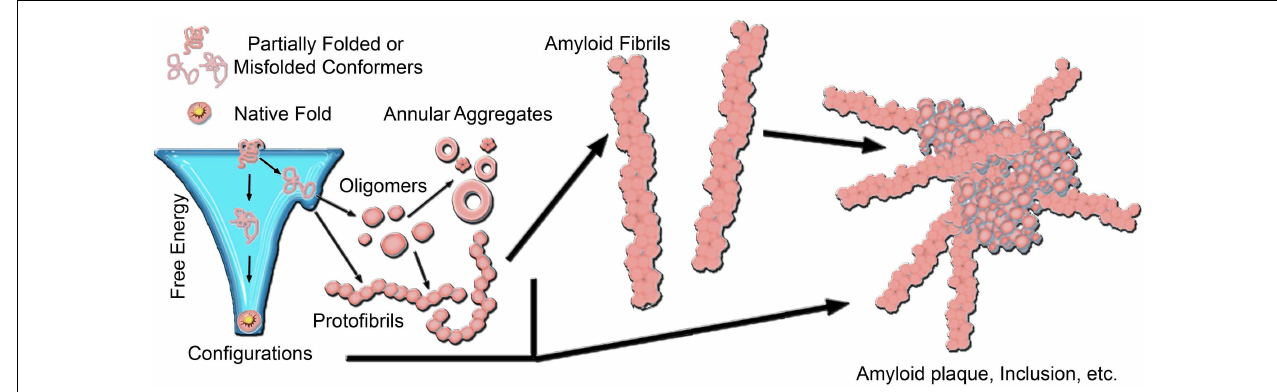
a heterogeneous mixture of intermediate species, including oligmers and protofibrils. Off-pathway aggregates can also form, such as annular aggregates.These aggregates accumulate into amyloid plaques or inclusions in the diseased brain.The aggregation pathway for any given amyloid-forming protein can vary considerably depending on the protein and its folding